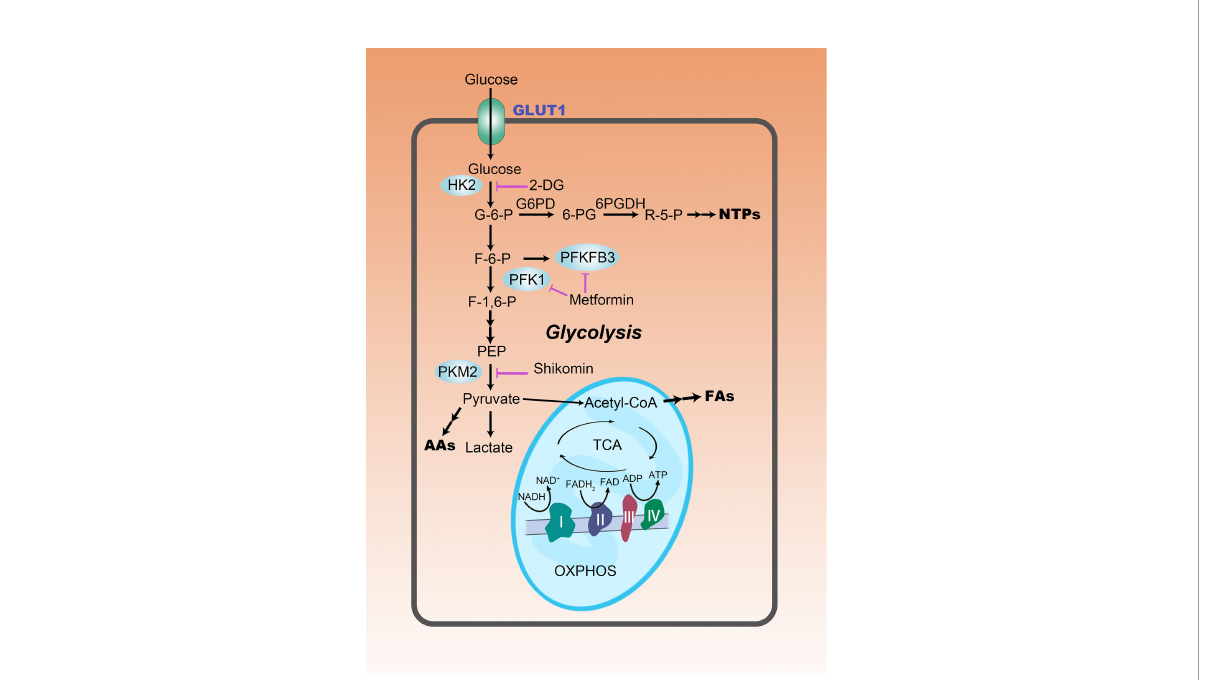
FIGURE 1 The rewiring of glucose metabolism in HCC cells. Glycolysis is abnormally active in HCC cells, even in a well-oxygenated environment. This reprogrammed metabolic pattern is manifested not only by increased glucose uptake, but also by increased lactate production. Enhanced aerobic glycolysis provides more carbon intermediates for the biosynthesis of nucleotides (NTPs), amino acids (AAs), and fatty acids (FAs), promoting anabolism in HCC cells. Purple lines represent metabolism-targeted drugs in clinical